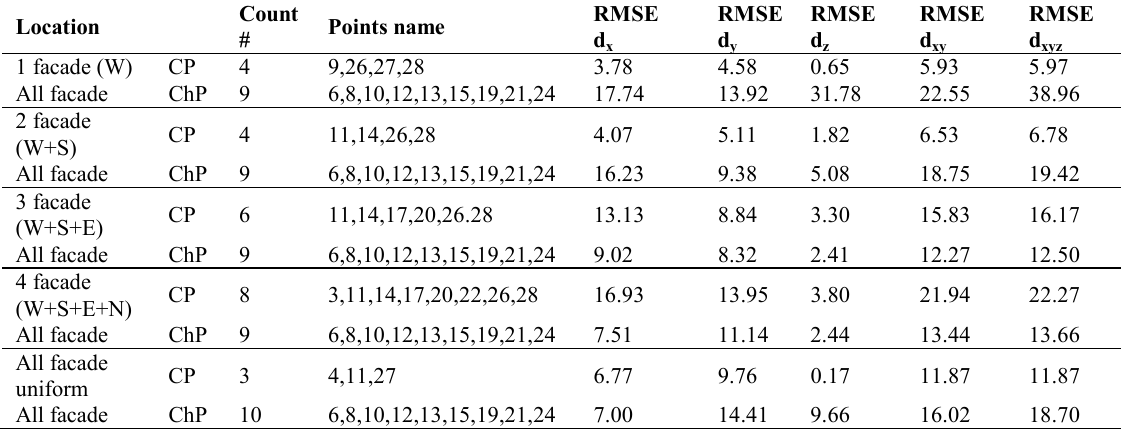
Table 3. Without loop close, RMSE of residuals on CPs and ChPs [cm]